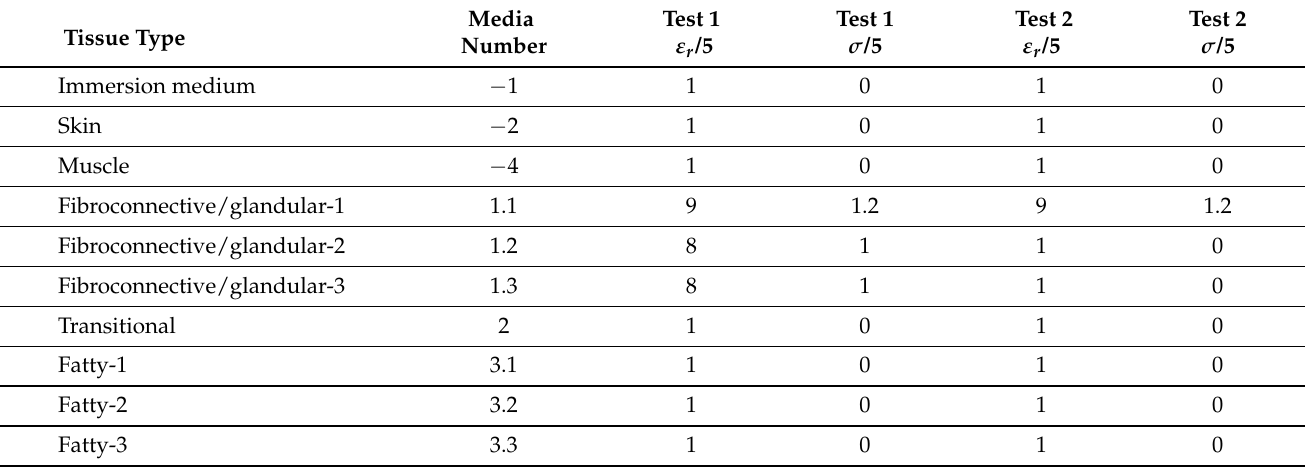
Table 1. Tissue types and corresponding media numbers of database [1] together with realistic weighted values of ε r and σ (S/m) for breast phantom with ID = 012204 used in numerical experiments of Section 5.2. Figure 3 presents media numbers of this table on original and sampled